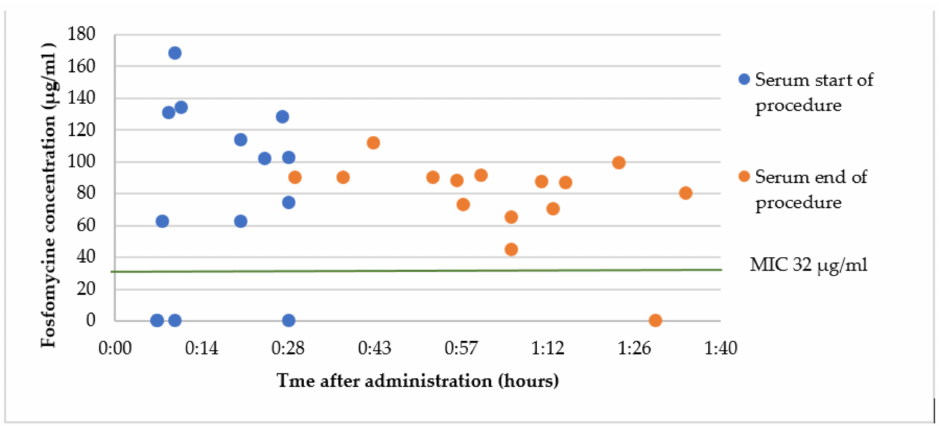
Figure 5. Fosfomycin concentrations in serum after a single intravenous dose immediately prior to surgery. Enterobacterales are considered susceptible to intravenous fosfomycin when MIC < 32 µ g/mL